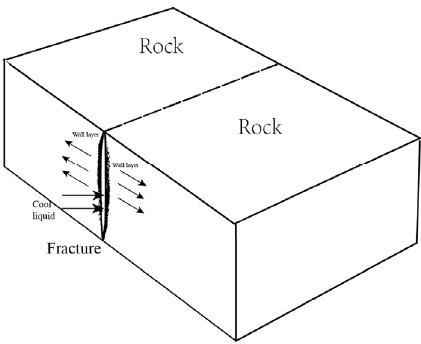
Figure 1. Physical model of the fracture temperature field for acid fracturing. The energy-coupling process between the fluid in the fracture and the bedrock of the formation is characterized by the following energy changes: Based on the established physical model, the acid flow within the fracture satisfies the law of conservation of mass. An element within the fracture is assumed according to the flow process, as shown in Figure 2.